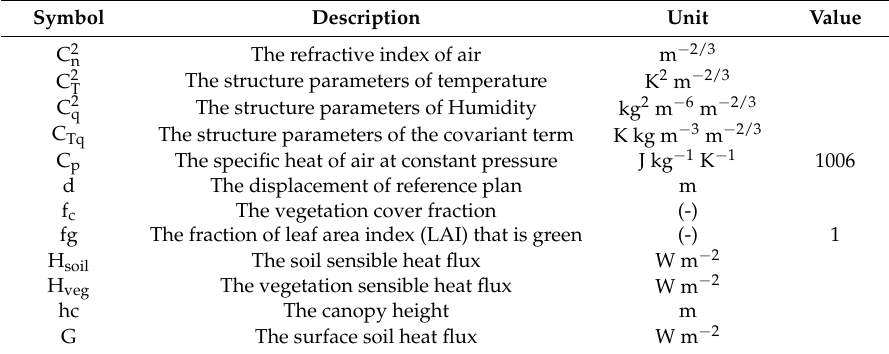
Table 1. List of variables used in the study.